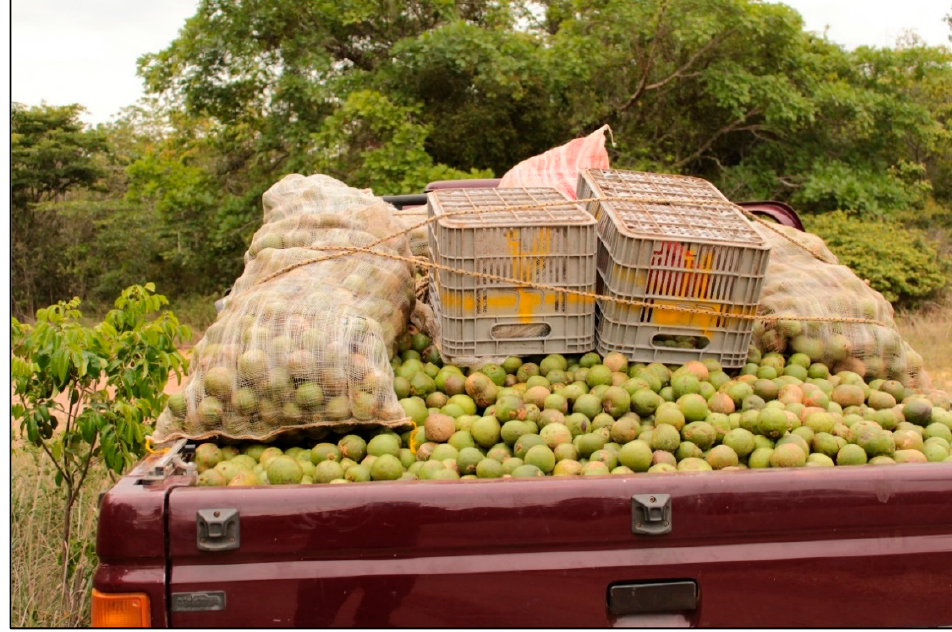
Figure 3. Car commonly used to transport Caryocar coriaceum Wittm. during the